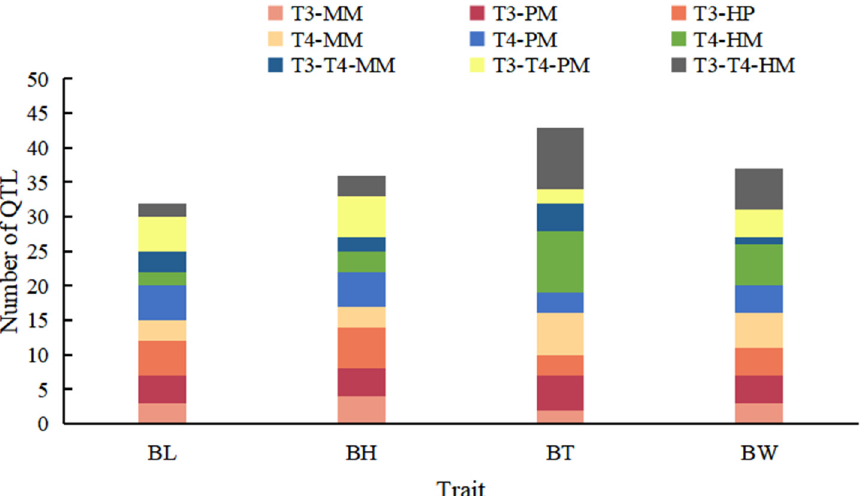
Figure 2. Distribution of QTLs for body length (BL), body height (BH), body thickness (BT), and body weight (BW) detected at three stages; MM, maternal map; PM, paternal map; HM, HH map; T1, 13 months after hatch (mah); T2, 17 mah; T1T2, 13–17 mah. Table 3. Consensus QTLs identified for growth traits.